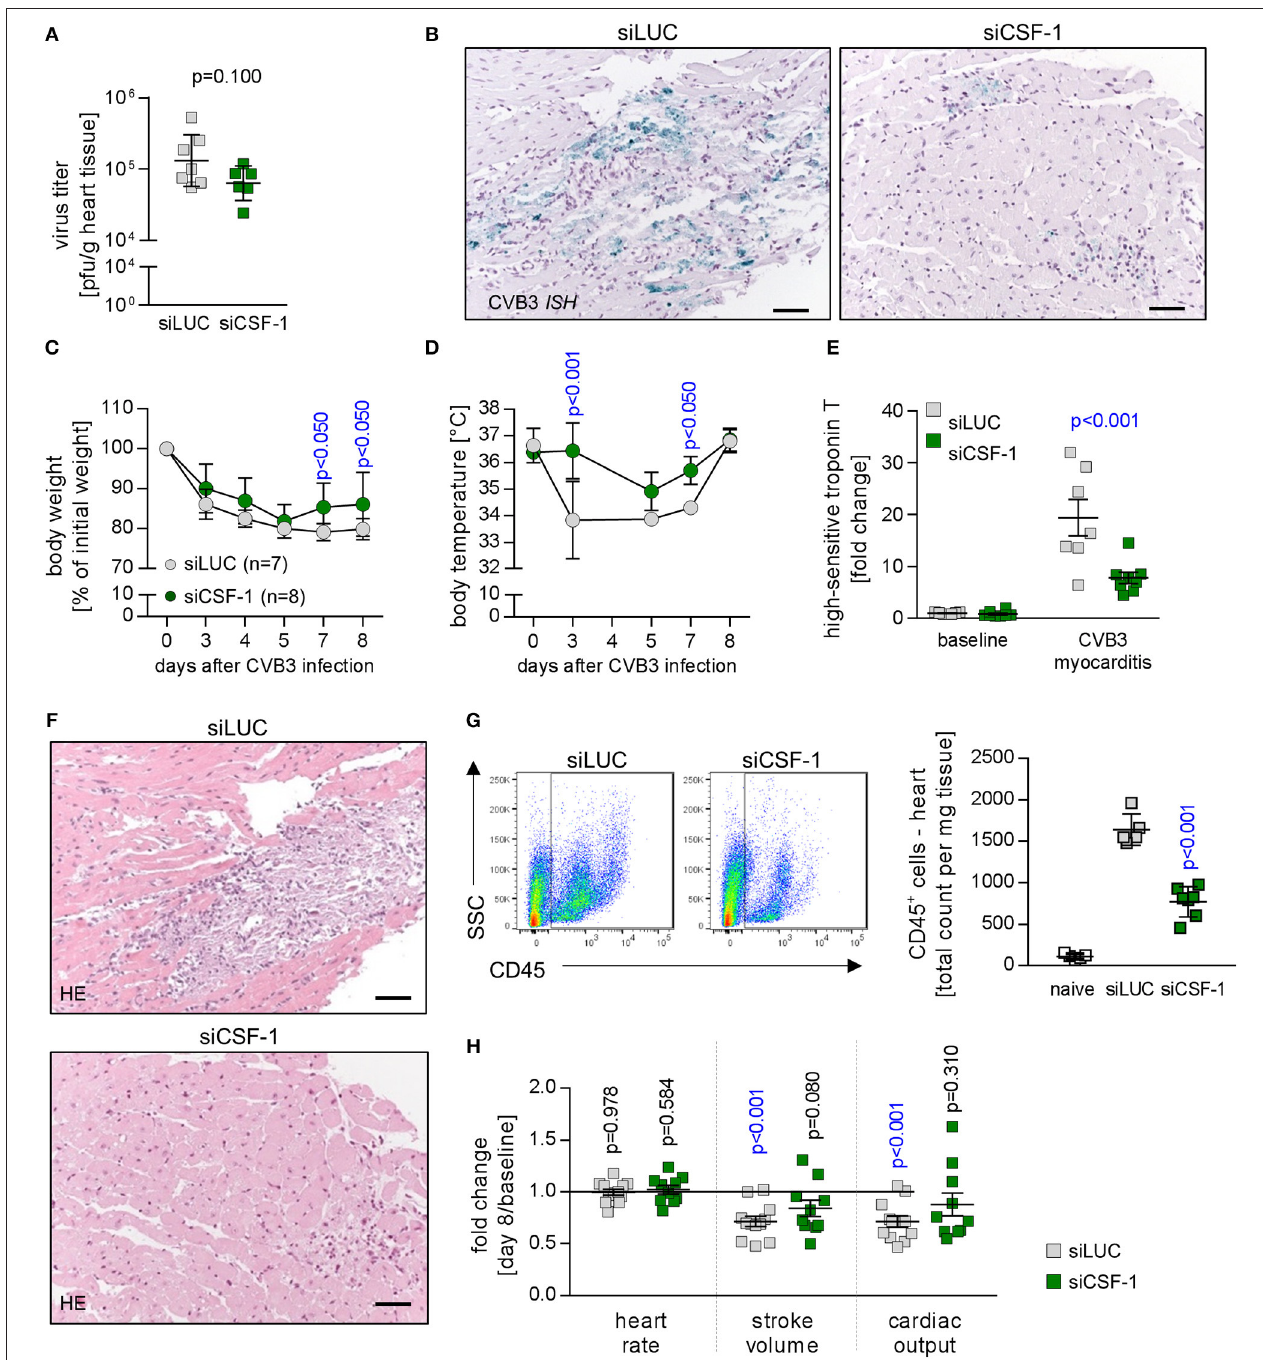
FIGURE 4 | Depletion of CSF-1 attenuates virus-mediated pathology. Mice with AVM were subjected to CSF-1 siRNA treatment as indicated in Figure 3D . (A) Infectious virus particles were determined in heart tissue homogenates by plaque assay. Data summary is mean ± SEM. A student‘s t -test was conducted and the p -value is shown. (B) To localize viral RNA in infected heart tissue, in situ hybridization for the detection of the CVB3 genome was performed and slides were counterstained with hematoxylin/eosin. Representative micrographs are depicted (scale bar = 60 µ m). During viral infection, mice were monitored for body weight (C) and body temperature (D) at the indicated points in time. Dots represent mean ± SEM. Repeated measurements versions of two-way ANOVA were performed followed by a Sidak- Holm multiple comparison procedure. P values are indicated (blue color indicates p < 0.05; only significant results are depicted on the graph). (E) To assess injury of cardiomyocytes prior to peak of inflammation, blood was sampled 5 days after infection by facial vein puncture and high sensitive (hs) troponin T plasma levels were determined. Obtained results were normalized to the results obtained with blood samples from non-infected siLUC-treated mice and are